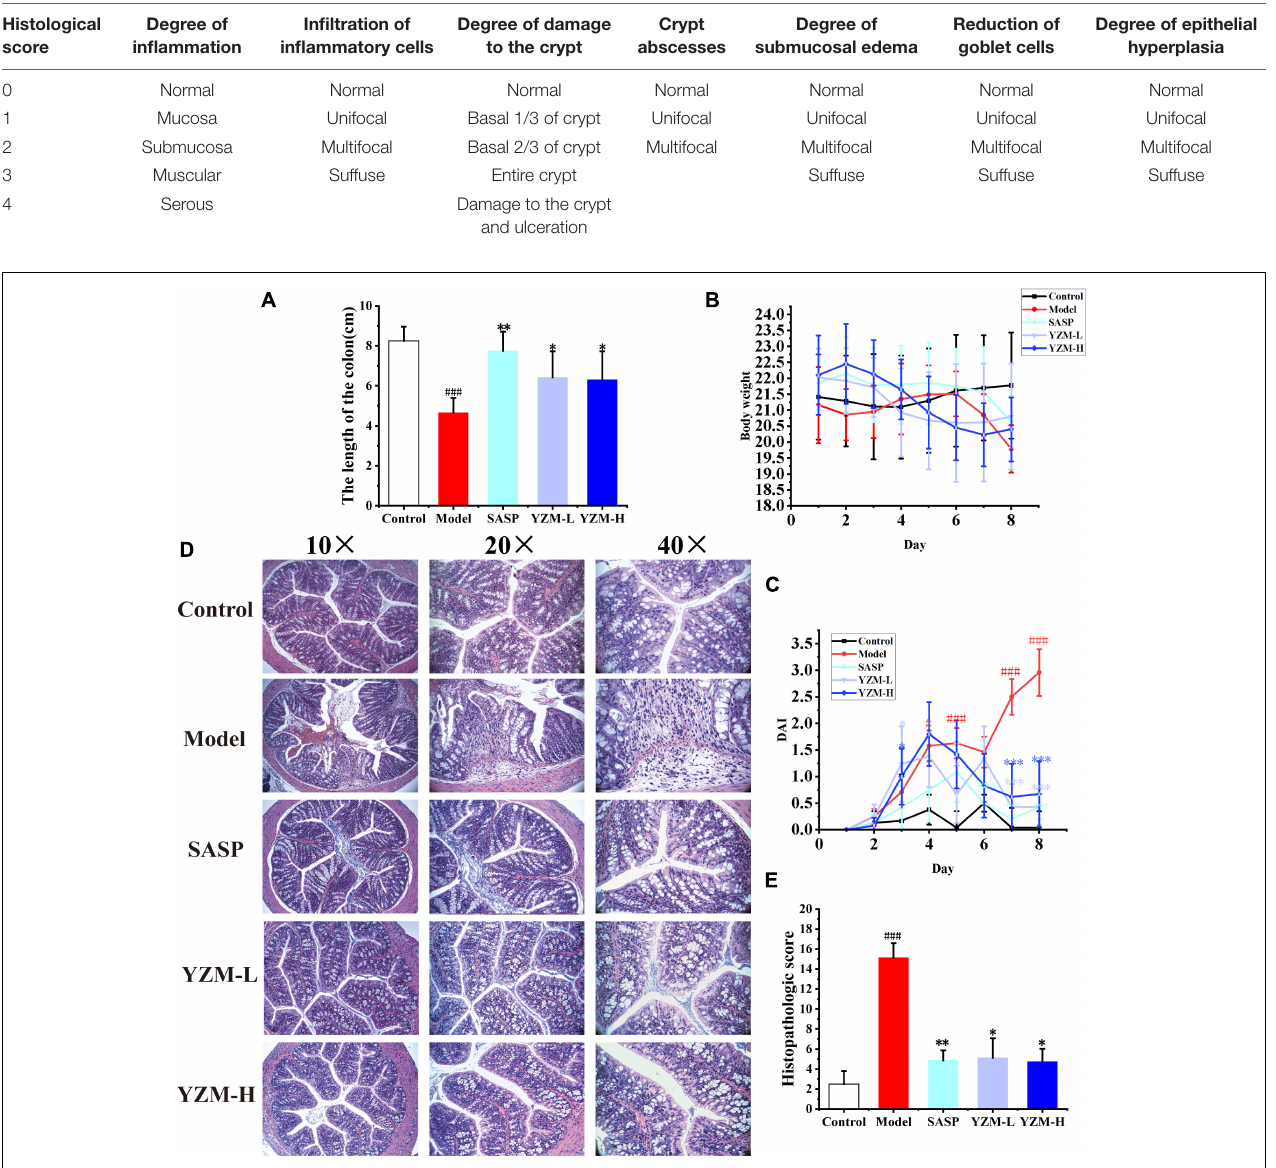
FIGURE 1 | The effect of YZM on colitis mice. (A) Analysis of colon length. (B) Body weight changes. (C) DAI changes. (D) Representative images of colon sections. (E) Histological score. ### p < 0.001 vs. control, ** p < 0.01 vs. model, * p < 0.05 vs. model.